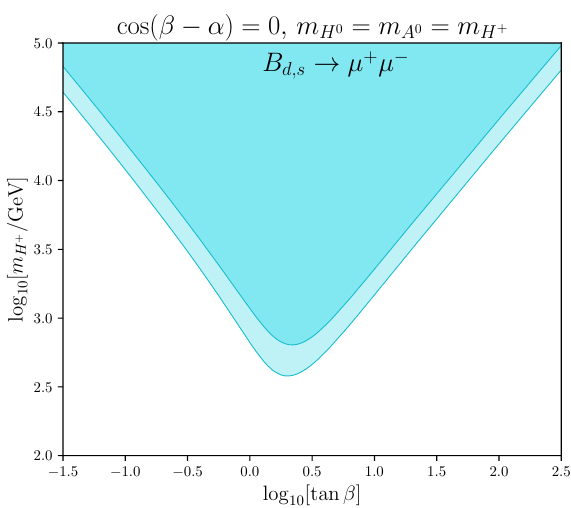
Figure 12. Contour plot of the allowed 2HDM-II parameter space in the (tan β − m for the FCNC leptonic B d,s → µ + µ − decays, fixing the additional parameters as cos( β − α ) = 0 , m = m = m . The lighter contour indicates the allowed parameter space at 2 σ confidence H 0 A 0 H + level while the darker contour corresponds to 1 σ